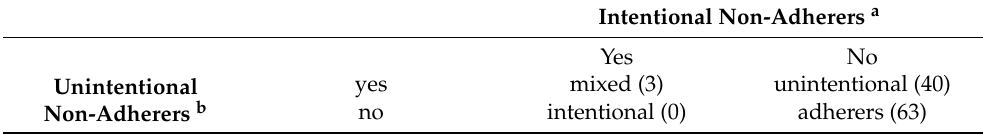
Table 3. Cross-tabulation analysis of the